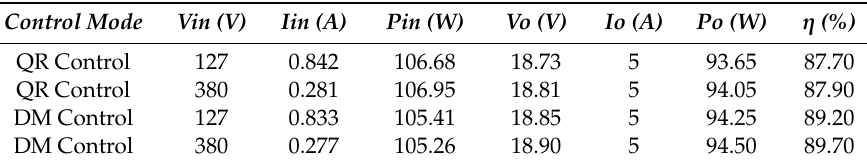
Table 2. Comparison with existing control mode.